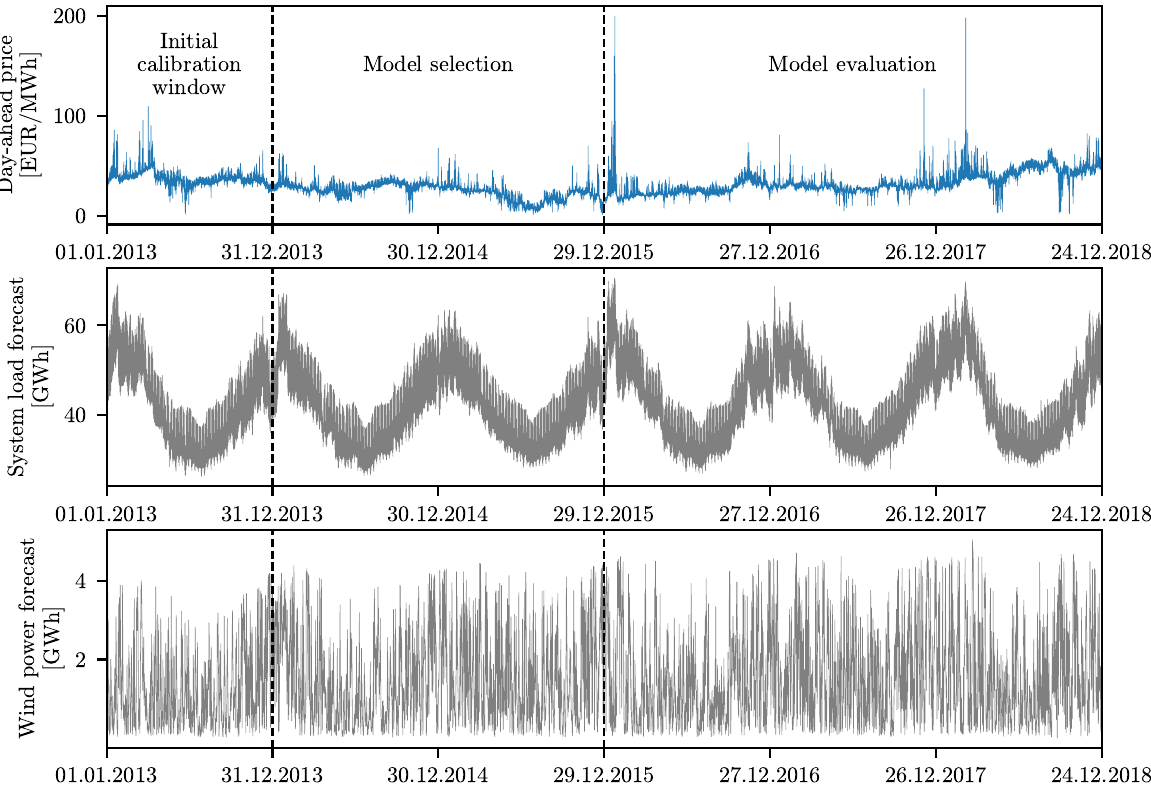
Figure 1. Day-ahead system prices in the Nord Pool electricity market (NP; top ) and two forward looking series: day-ahead system load forecasts ( middle ) and day-ahead wind power generation forecasts for Denmark ( bottom ). The vertical dashed lines indicate the beginnings of the model selection (31 December 2013) and model evaluation (29 December 2015)